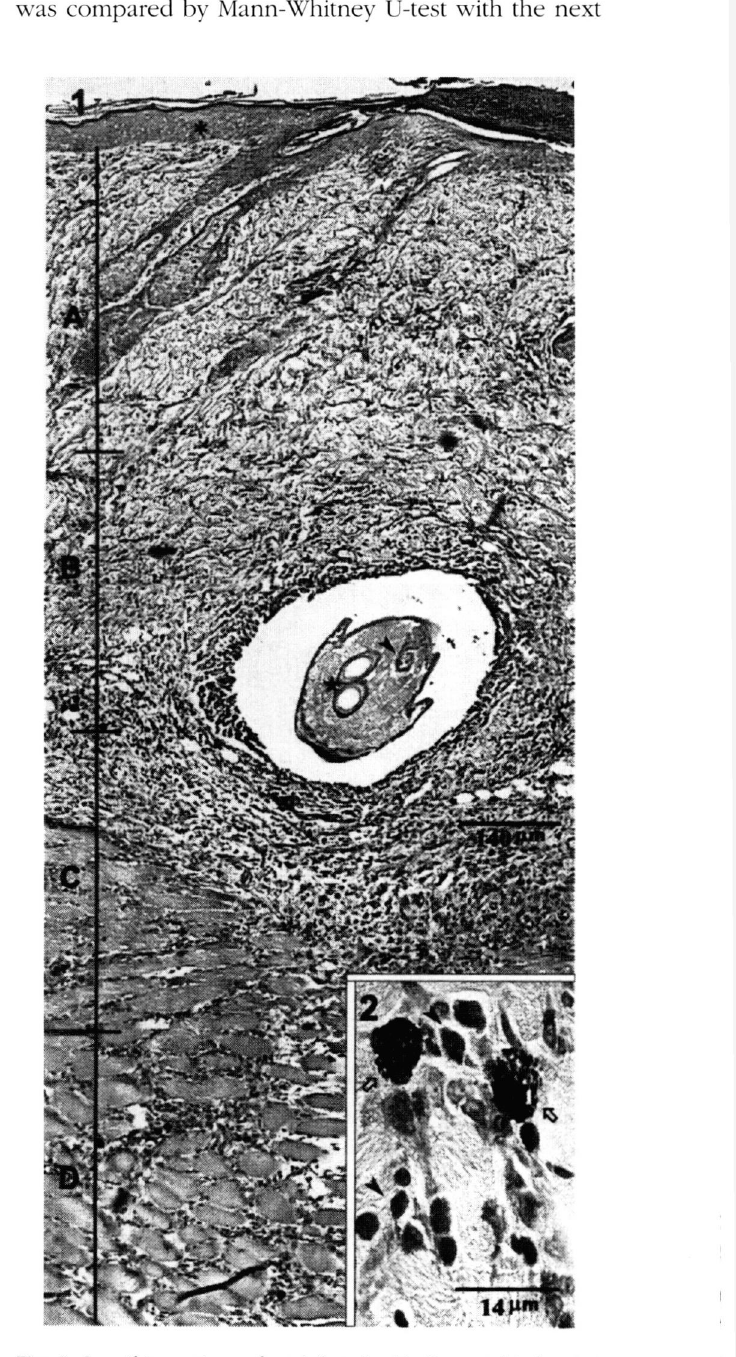
Figs 1, 2. - Skin sections of rat infested with Dermatobia hominis larvae. (1) Typical example at four days post-infestation, indicating the regions (A, B, C and D) where the eosinophils and mast cells were counted. Asterisk = epidermis, star = two larval tracheoles and arrowhead = larval gut. (2) Eosinophils (arrowheads) and mast cells (arrows) at 10 days